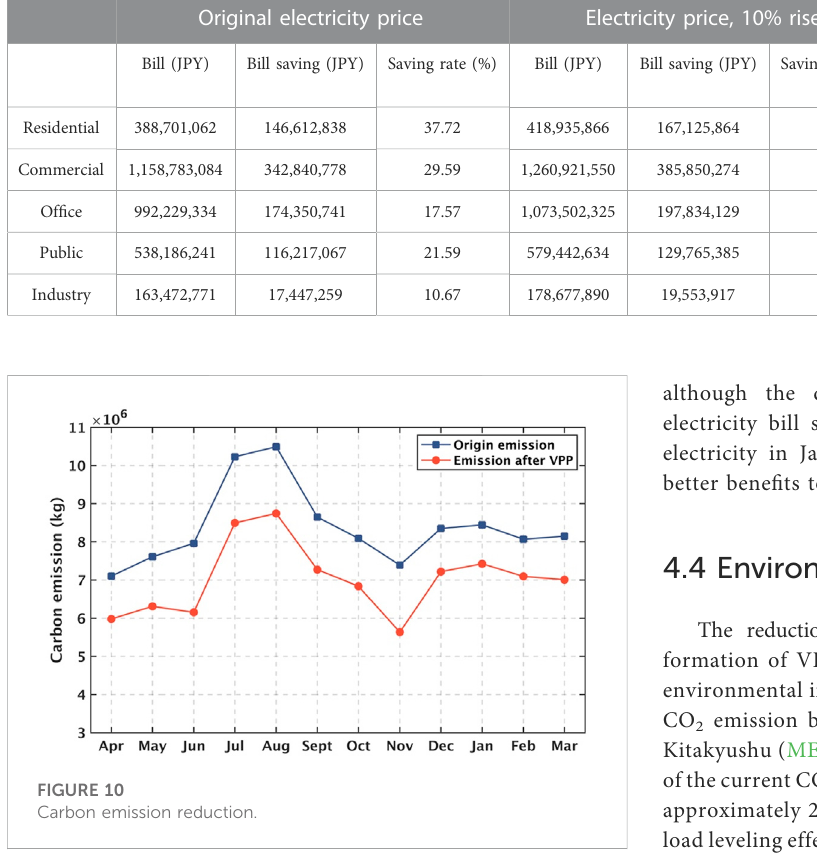
TABLE 7 Summary of the VPP annual electricity bill saving considering different electricity prices. Original electricity price